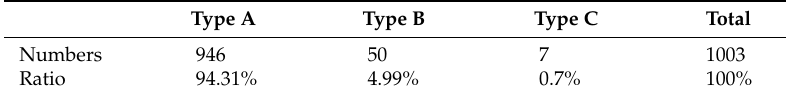
Figure 14. Partial recognition results of MSB. From left to right: raw image, segmentation of neuron, segmentation of synapses, and the comparison of the segmentation of synapses and the ground truth of synapses, where the yellow pixels represent true positives, red pixels represent false positives, and green pixels represent false negatives. Table 5. Statistics of different types of